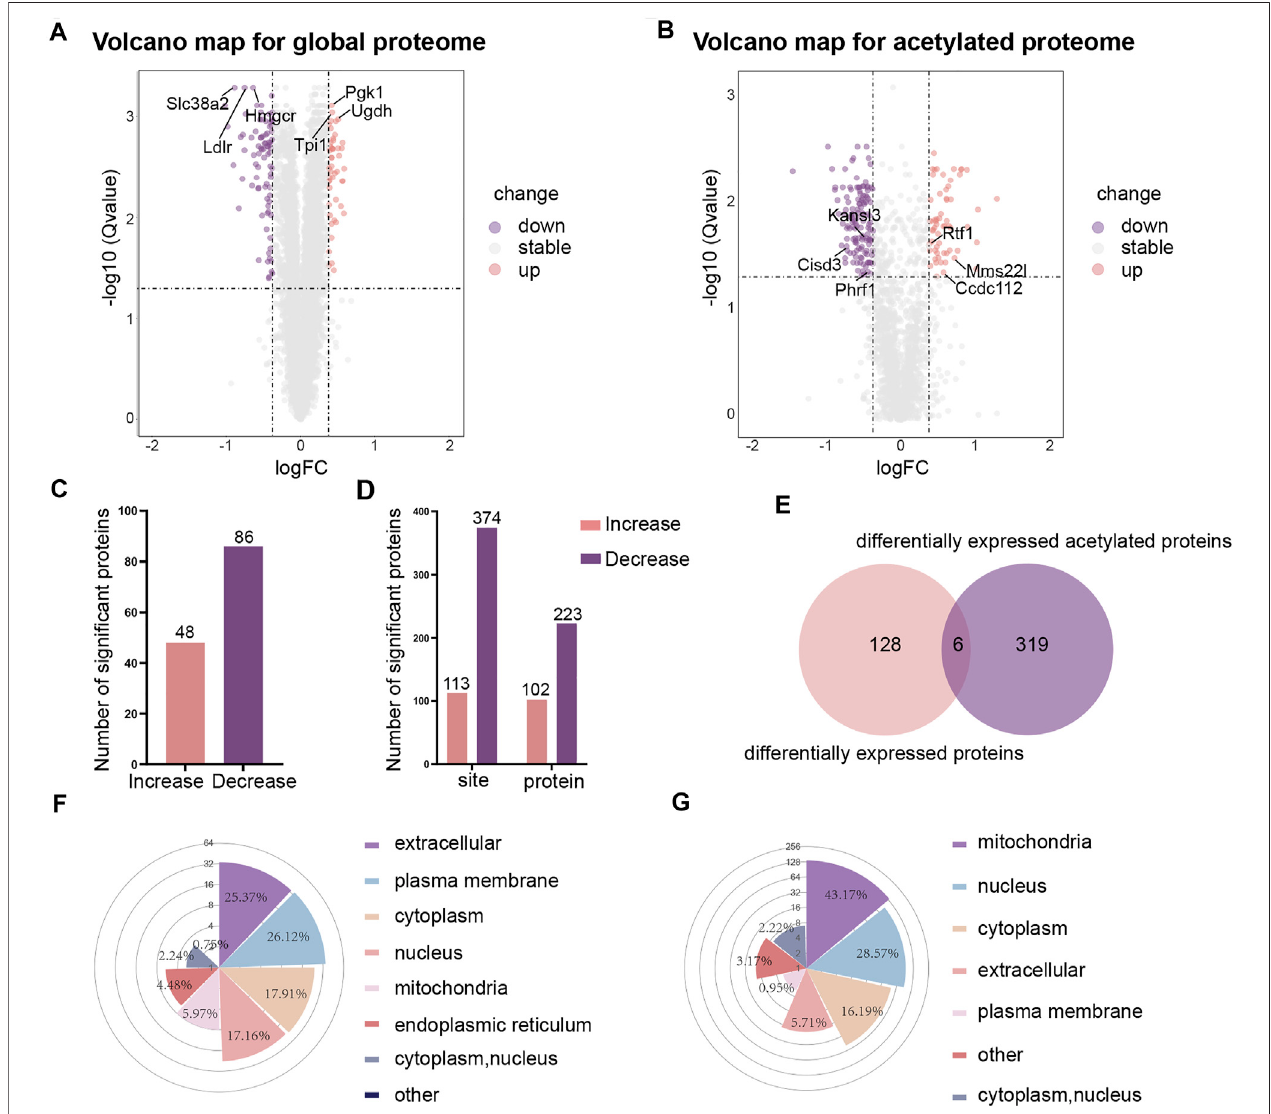
FIGURE2| Thedifferentialanalysisandsubcellularlocalizationofglobalproteomeandacetylatedproteome. (A) Volcanomapofdifferentiallyexpressedproteinsin global proteome. (B) Volcano map of differentially expressed proteins in acetylated proteome. (C) Histograms showing differentially expressed proteins in global proteome. (D) Histograms showing differentially expressed acetylated proteins. (E) Venn diagrams showing differentially expressed proteins in global proteome and acetylated proteome. (F) Rose plots showing the subcellular localization of differentially expressed proteins in global proteome. (G) Rose plots showing the subcellular localization of differentially expressed acetylated